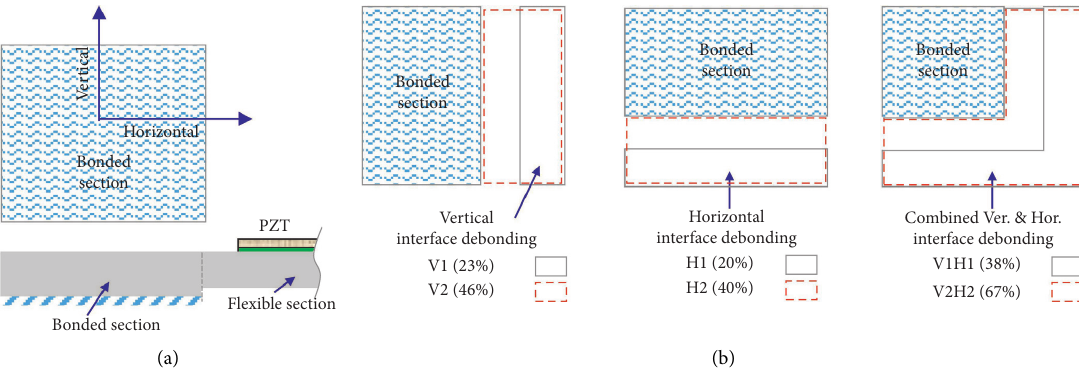
Bonded section Figure 25: Shifts in peak frequencies caused by PZT breakage defects. (a) Cases: V1, V2. (b) Cases: H1, H2. (c) Cases: V1H1,